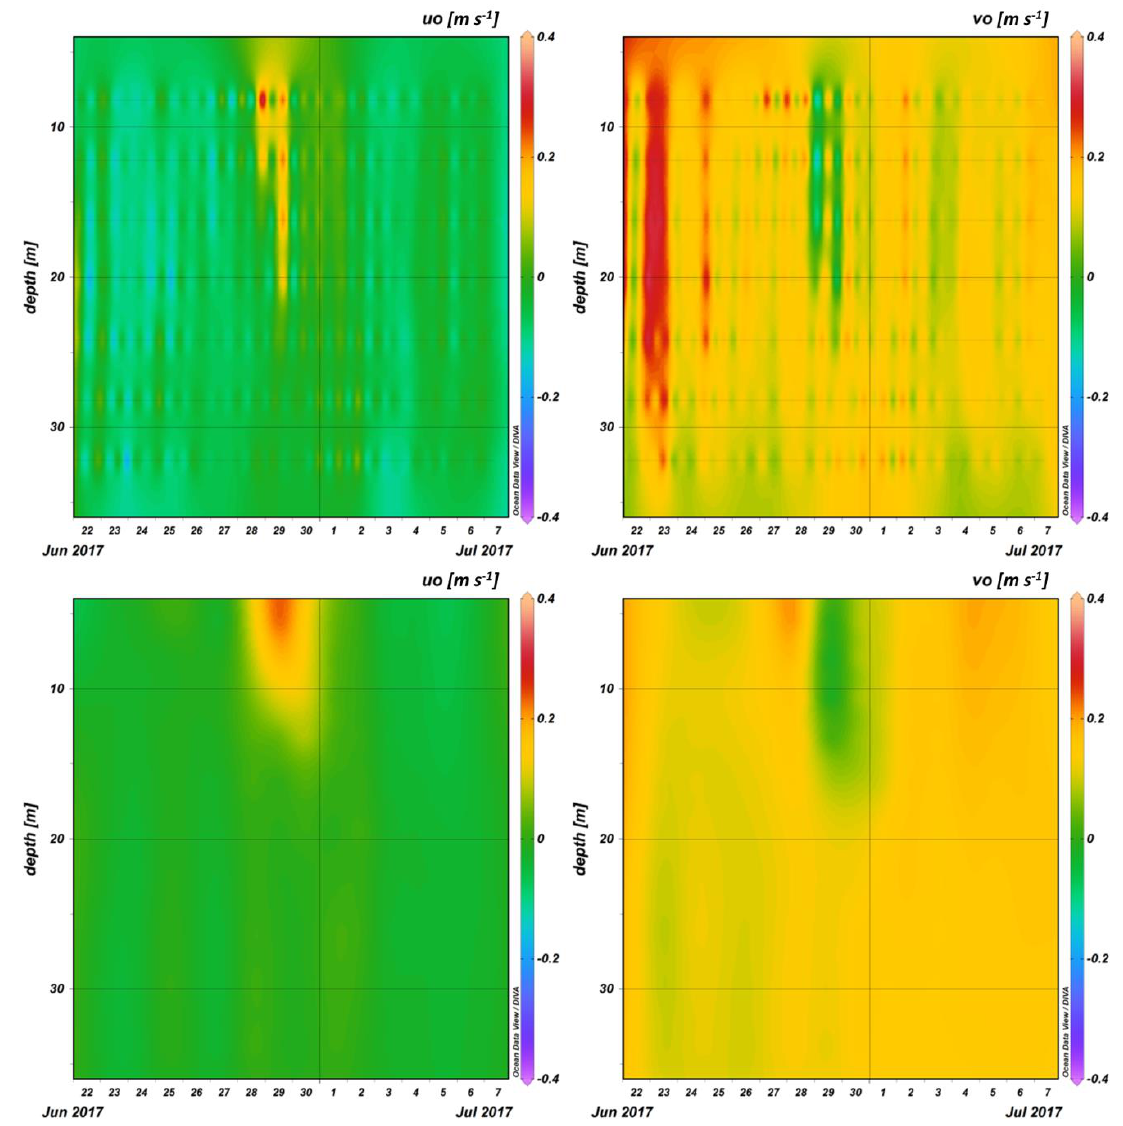
Figure 17. East and north current components trend over time, with respect to depth (top row: experimental data measured by the ADCP-bottom row: data obtained from the CMEMS forecast model).